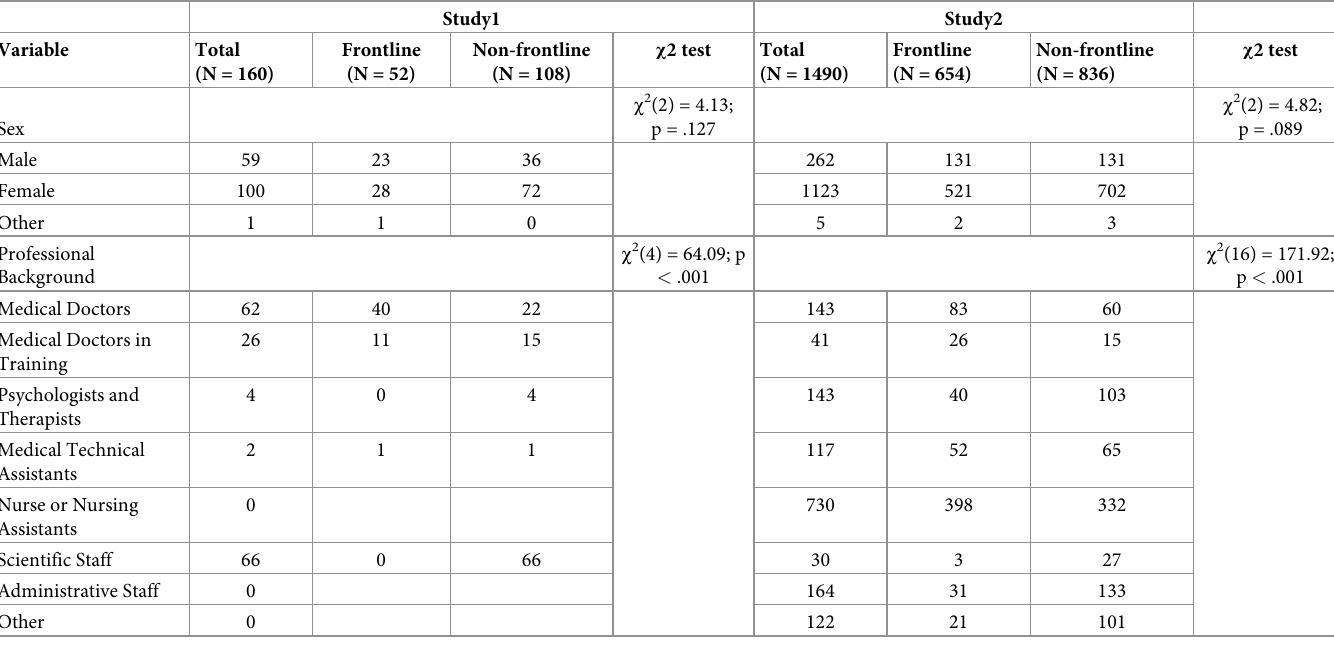
Table 1. Sociodemographic characteristics of the study participants.